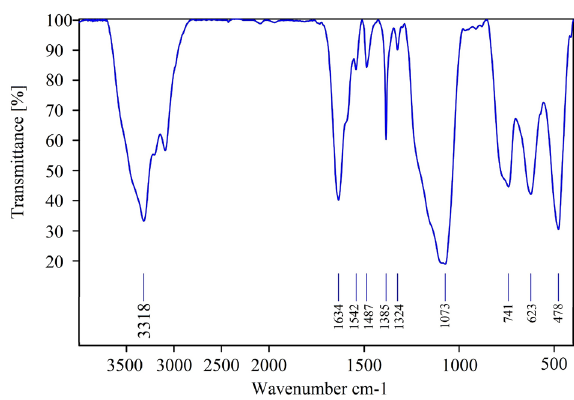
Figure 8. FT-IR spectrum of Cu(II)-MP-bis(AMP)@boehmite.